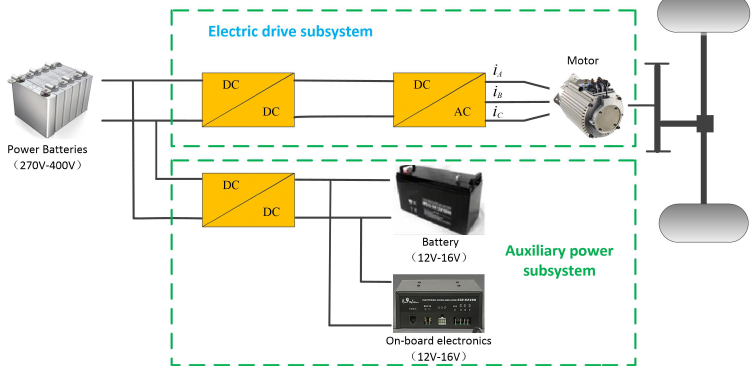
Figure 1. Diagram of EVs energy flow.